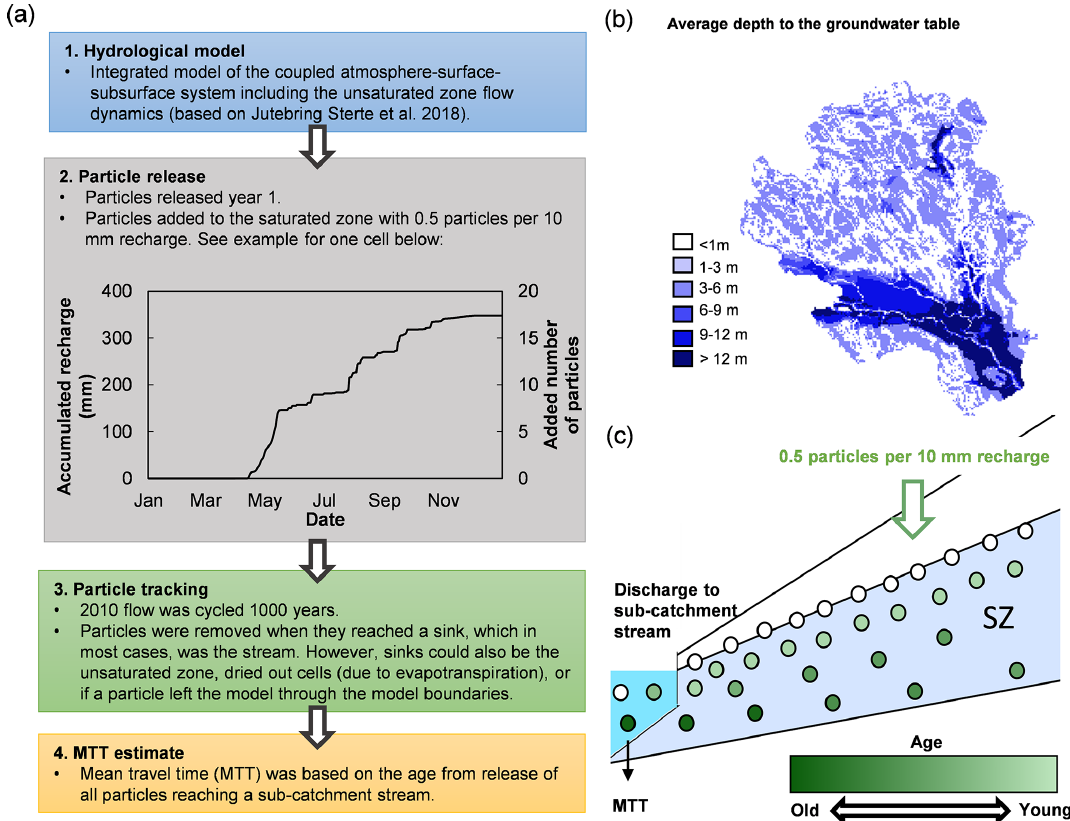
Figure 4. Particle model setup. (a) Steps of particle tracking. (b) Average depth to the groundwater table. The main part of the model area has a calculated depth to the groundwater table between 0 and 3m and varied daily. (c) Schematic illustration of particle-tracking setup. Particles were added to groundwater recharge at the transient groundwater table. The age of these particles was zero at the time of recharge. Thereafter, they followed the groundwater flow, increasing in age until reaching a stream or